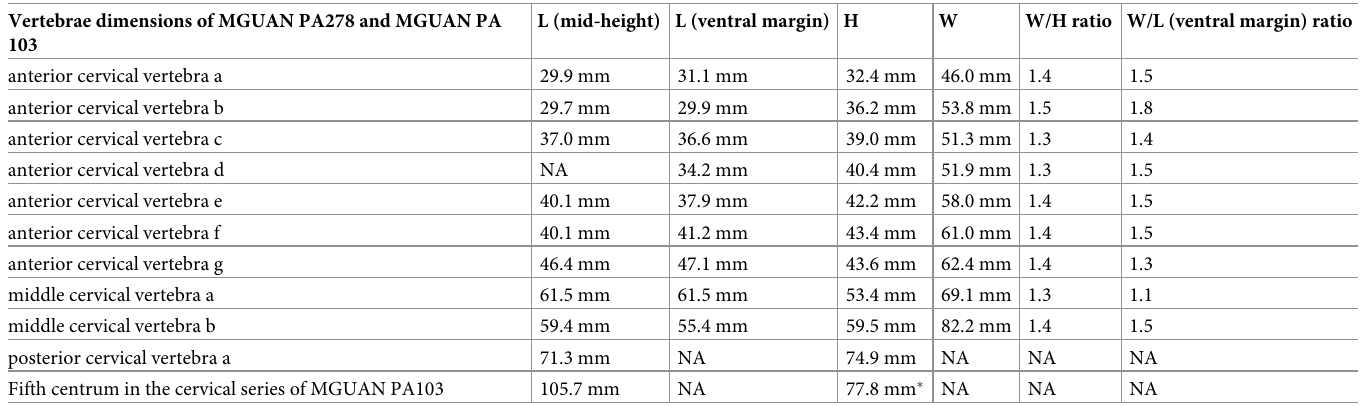
Table 2. Centrum dimensions for cervical vertebrae associated with MGUAN PA278 and MGUAN PA103. Vertebrae dimensions of MGUAN PA278 and MGUAN PA 103 anterior cervical vertebra a